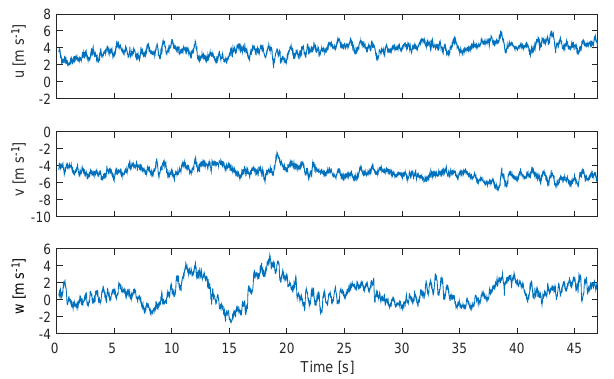
Figure 14. Example for the time series of the wind components u , v and w in the meteorological coordinate system derived from the SUMO 5HP system in a temporal resolution of 100Hz. The data for one single leg of flight # 29 on 19 June 2011 between 15:50:37 and 15:51:23UTC are